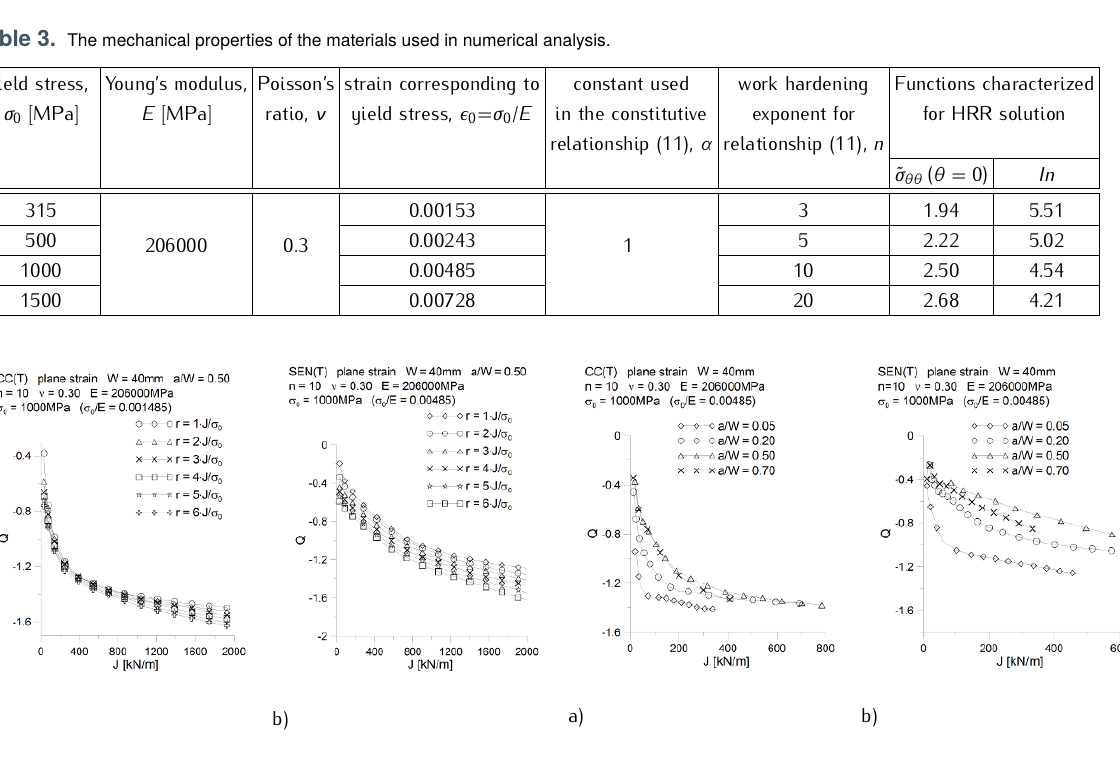
Figure 7. ‘The J - Q family curves” for CC(T) and SEN(T) specimens calculated at six distances r for plane strain - a / W =0.50, n =10, σ 0 =1000 MPa.